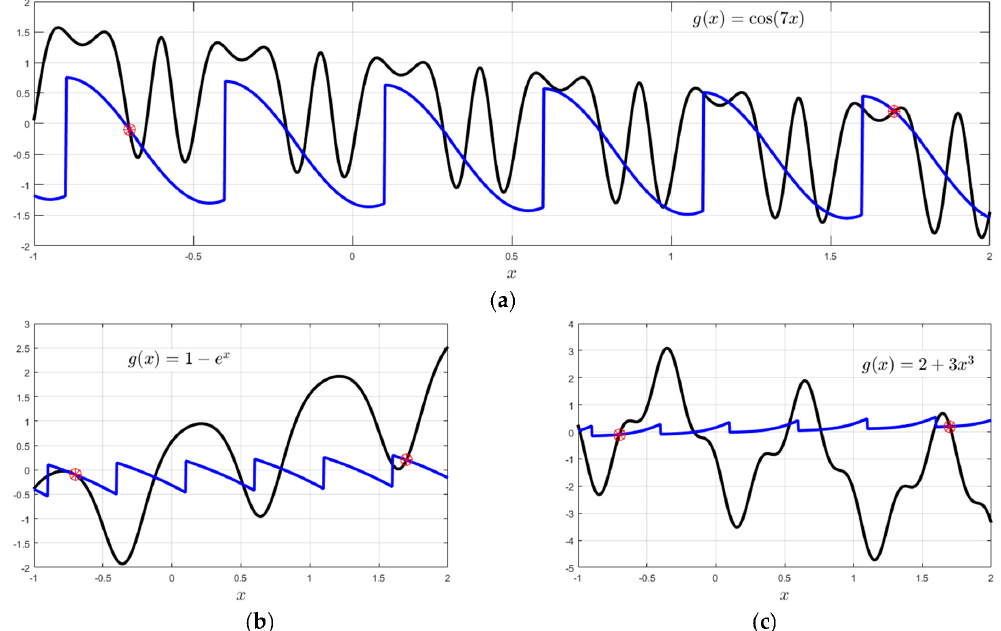
Figure 2. Examples of continuous and discontinuous periodic functions for different free functions, g ( x ) . ( a ): g ( x ) = cos ( 7 x ) , ( b ): g ( x ) = 1 − e x , and ( c ): g ( x ) = 2 + 3 x 3